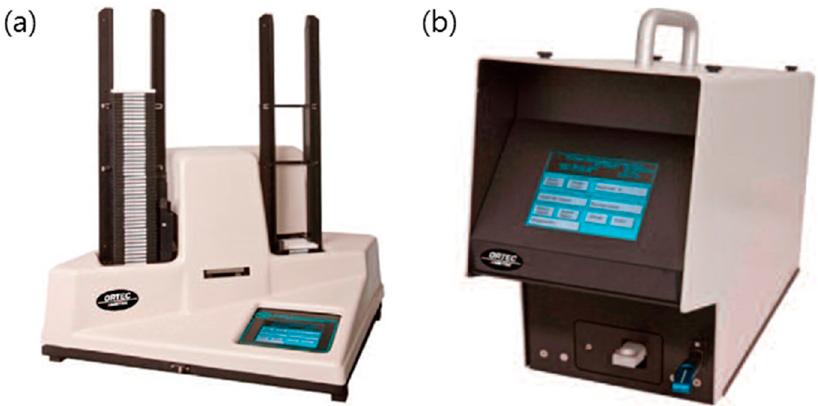
Figure 10. Dual phosphor type counter: ( a ) ASC-950-DP automatic sample changer and ( b ) MPC-900-DP manual single sample changer [70,71].